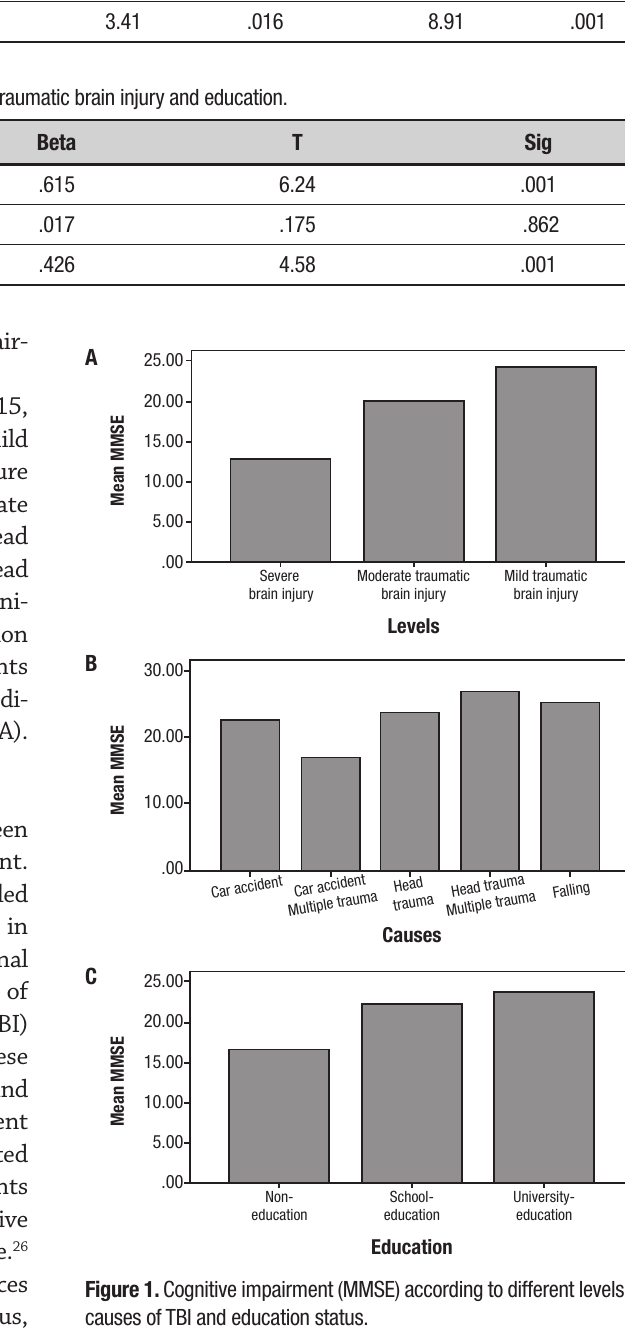
Cognitive impairment